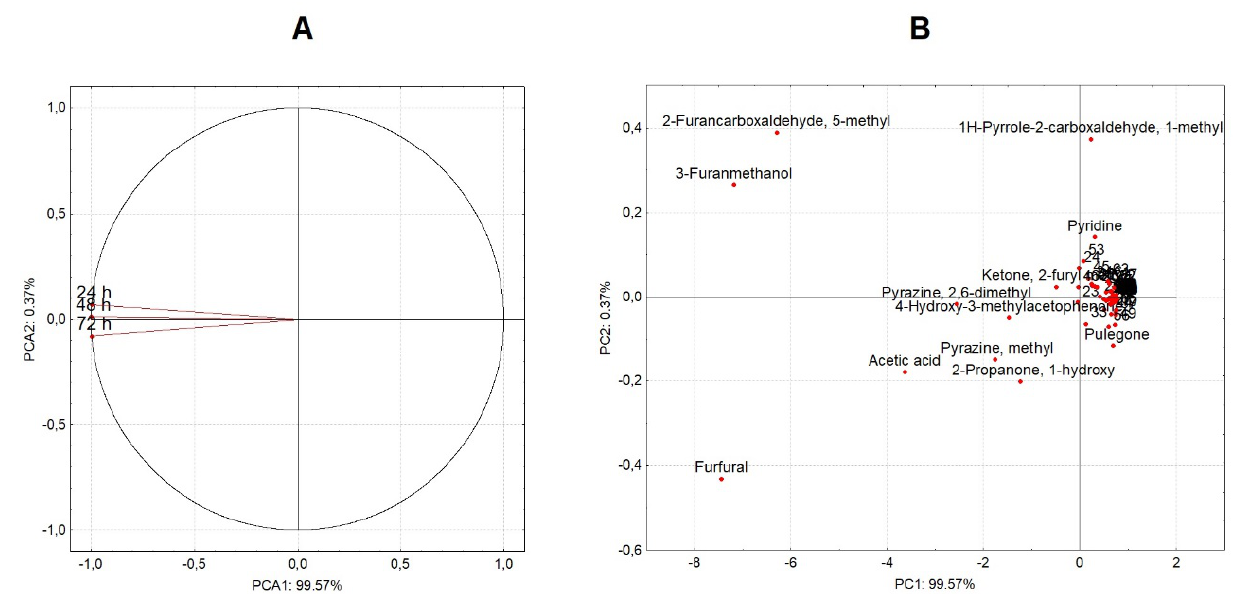
Figure 7. A principal component analysis based on weighted UniFrac Distances. ( A ) Analysis of volatile compounds detected in roasted coffee beans processed for 24, 48, and 72 h and ( B ) dispersion of these compounds in the three treatments.